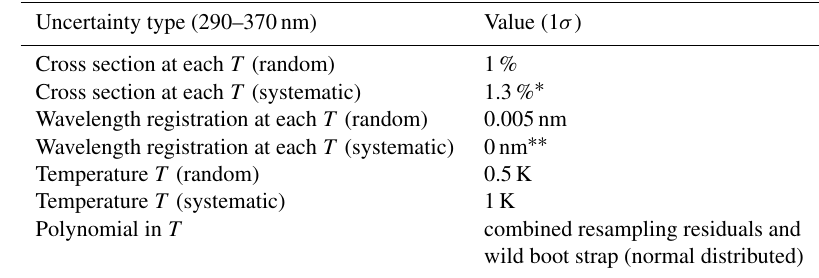
Figure 5. Panels (a) and (b) : 1 σ uncertainty of BP, BDM, and SG ozone cross sections at T = 193 and 227K, respectively, from the polynomial temperature fit (Eq. 5). Note the change in scale of the ordinate axes. Panels (c) and (d) : measured ozone cross sections (points) and polynomial fit (solid lines) for BP, BDM, and SG at 306 and 319.4nm, respectively. Table 8. Uncertainties accounted for in the Monte Carlo simulation assuming a Gaussian